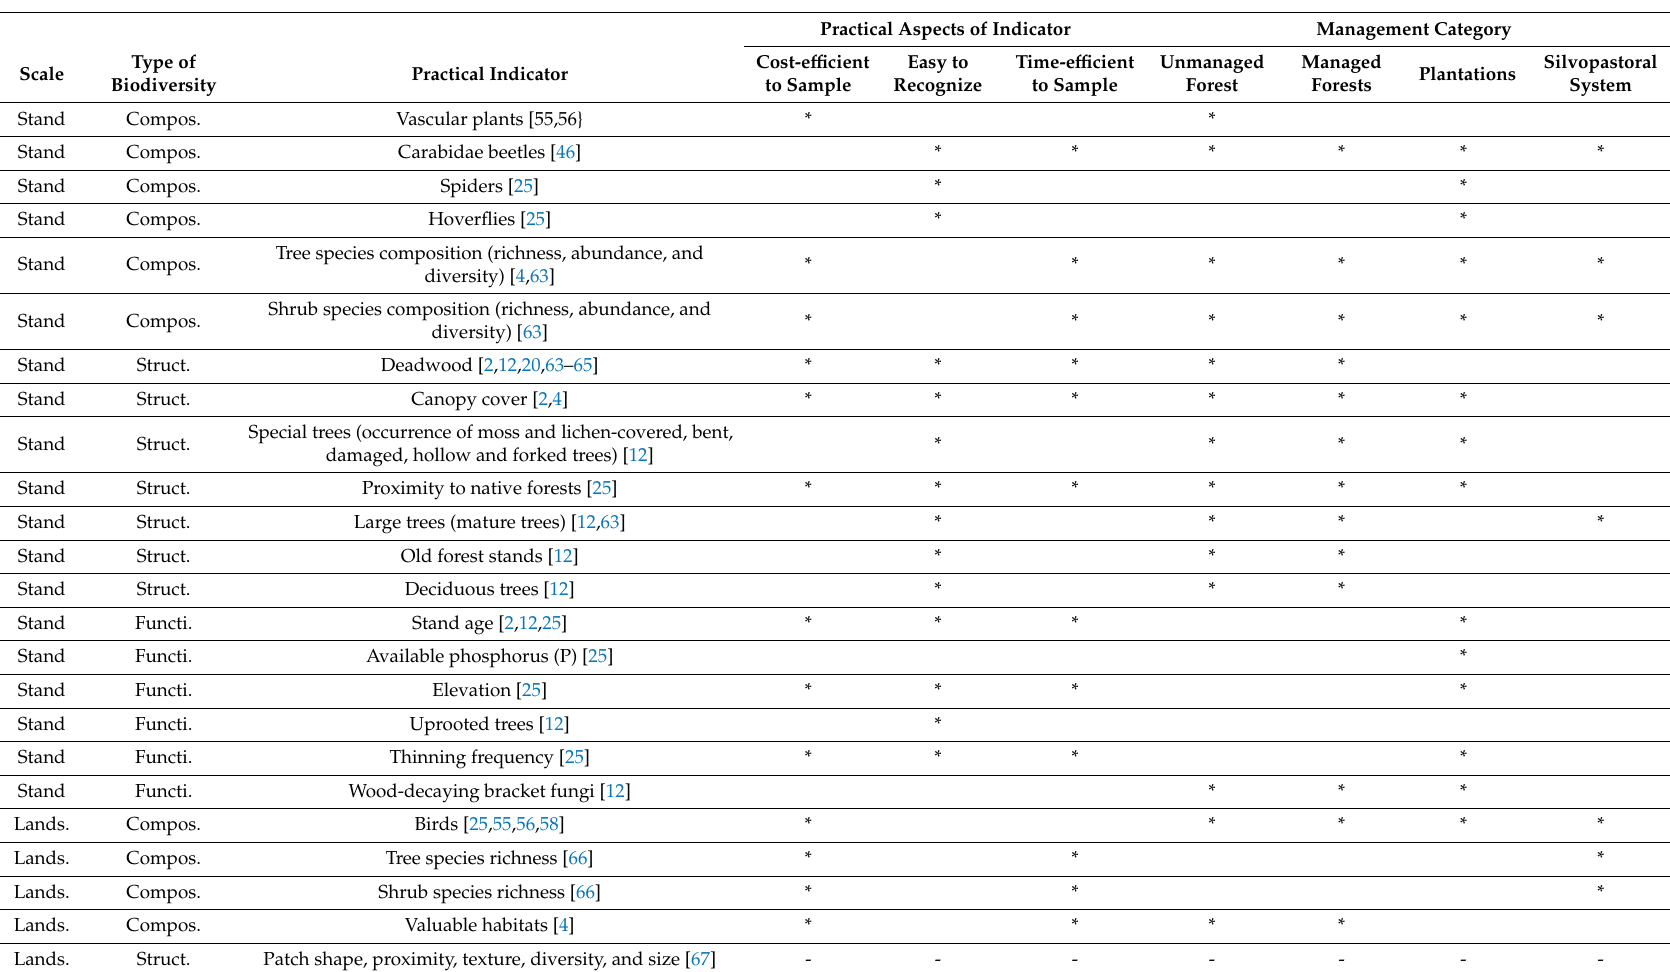
Practical Aspects of Indicator Management Category